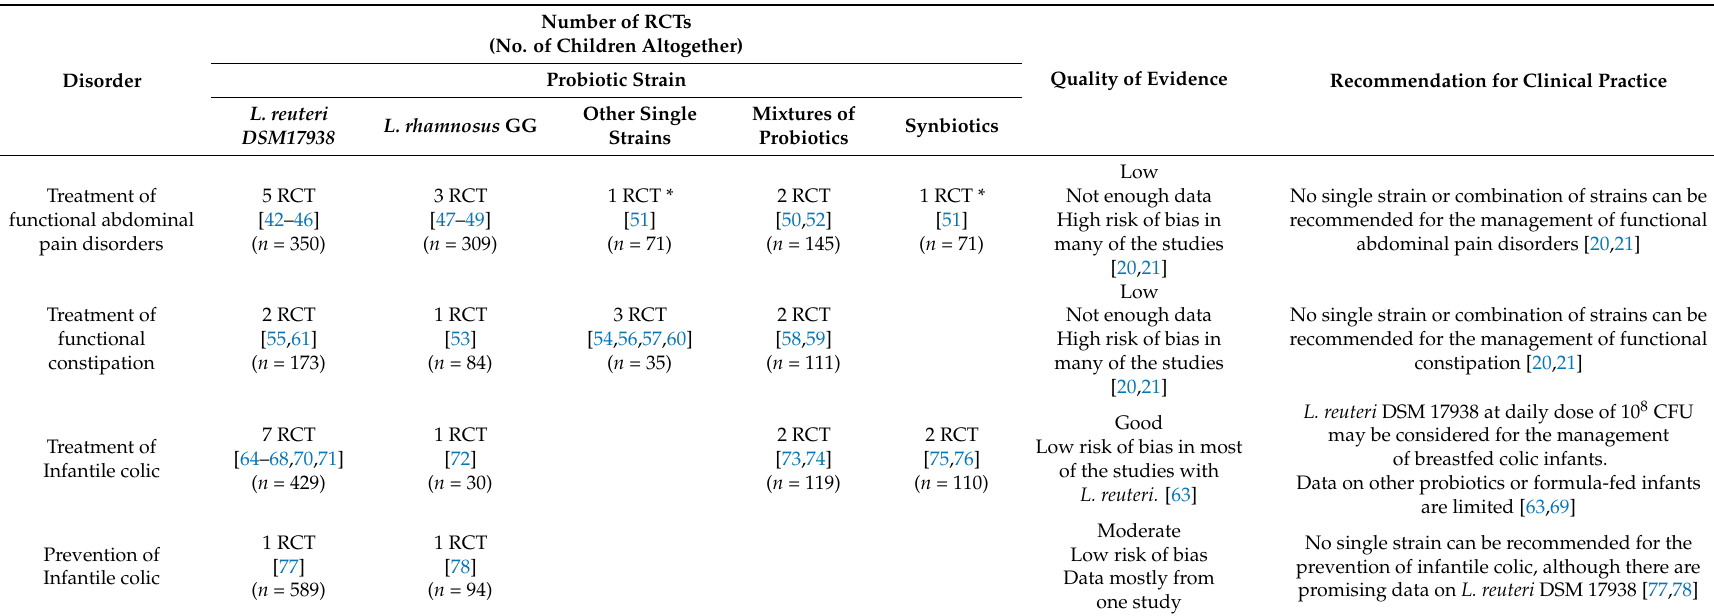
Table 1. Probiotics in children with functional gastrointestinal disorders. Summary of the RCT trials included in the review, quality of evidence and recommendation for clinical